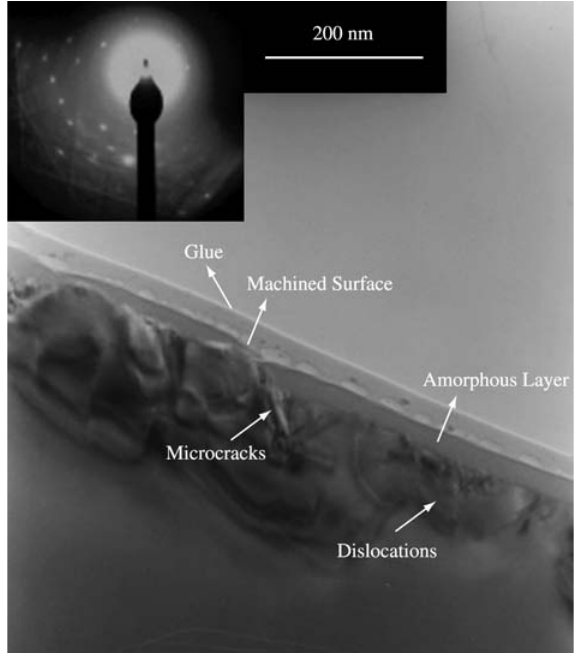
Figure 8. TEM cross sectional image of the machined sample and the dif- fraction pattern respectively.